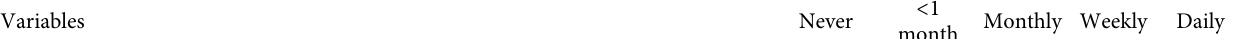
Table 6: Adherence to moderation of alcohol consumption among hypertensive patients in a follow-up clinic of Asella Referral and